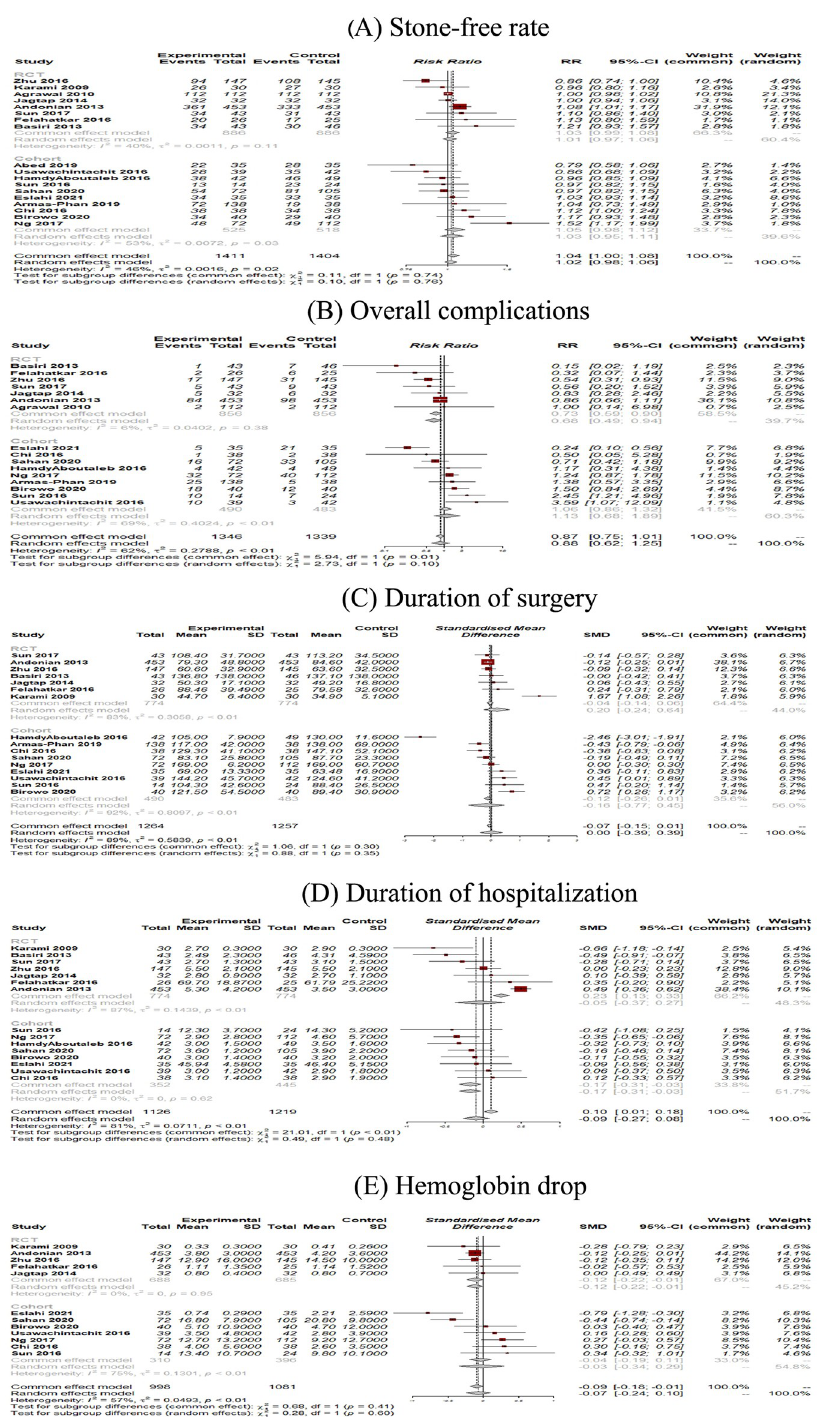
Fig 2. Forest plots of primary outcomes of UG-PCNL (experimental) versus FG-PCNL (control).